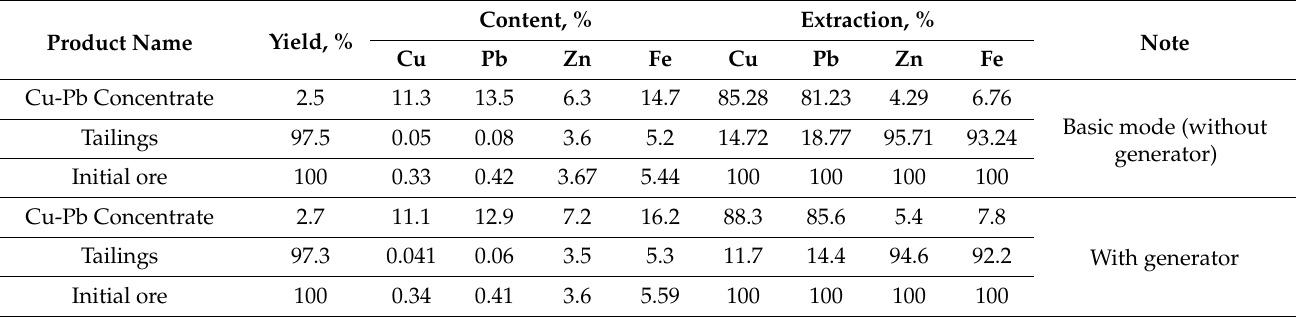
Table 6. Copper-lead flotation results in the basic mode and with the use of WAME generator.